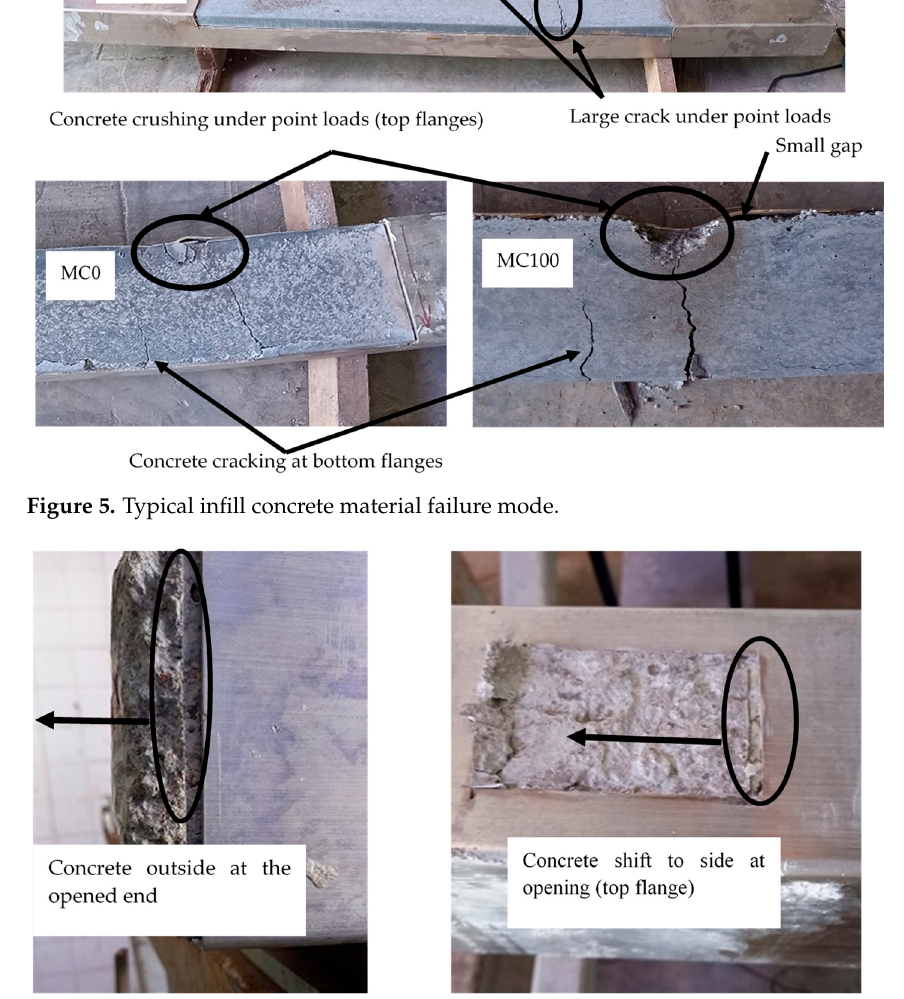
Figure 6. Typical extreme failure of in fi ll concrete at the suggested openings.